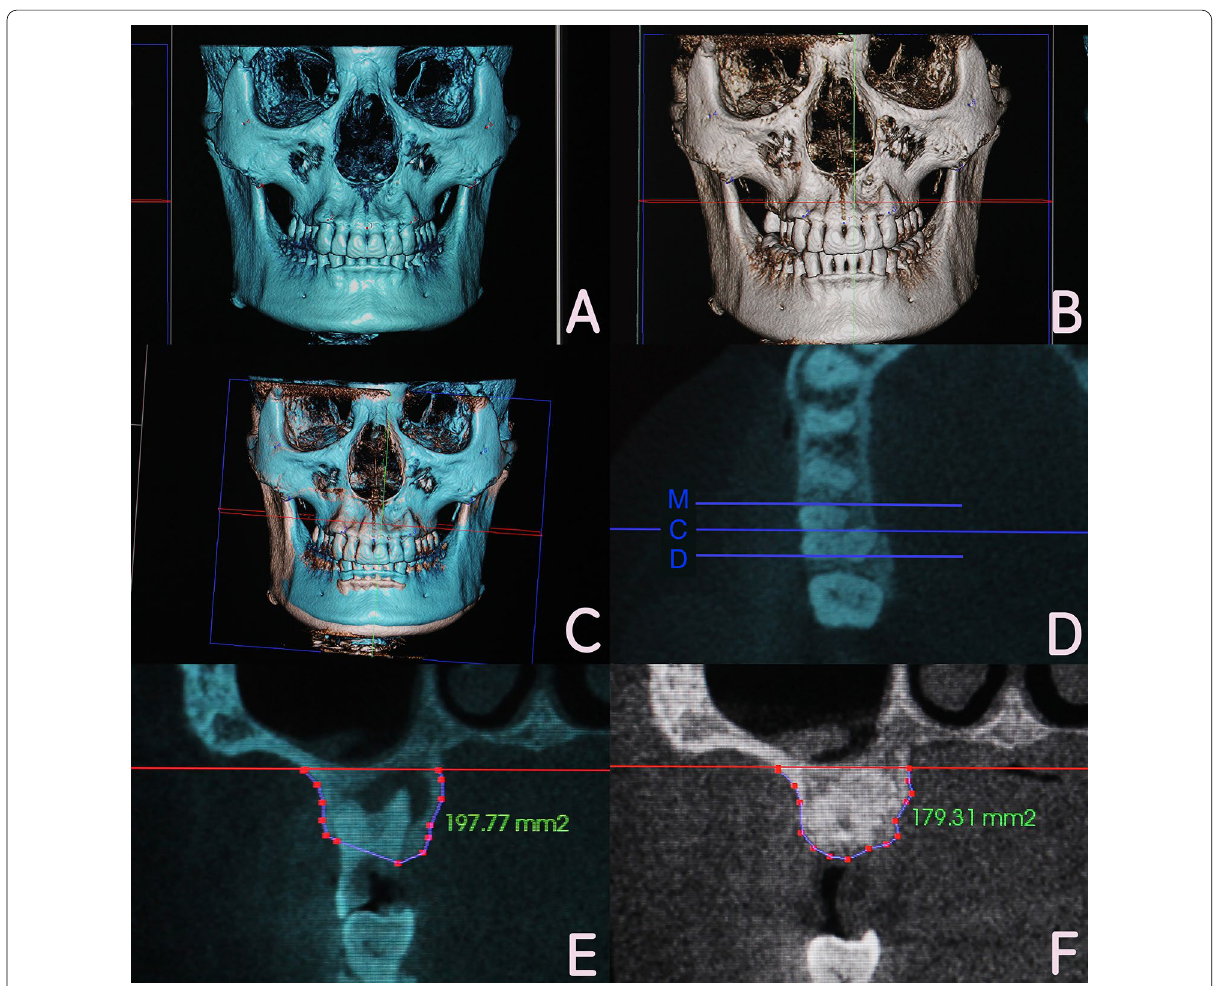
Fig. 2 CBCT observation and measurement method. a Preoperative three‑dimensional image; b 8‑month postoperative three‑dimensional image; c three‑dimensional image after superimposition; d C‑, M‑, D‑section were determined on the superimposed images; e the preoperative alveolar bone area was measured; f the 8‑month postoperative alveolar bone area was